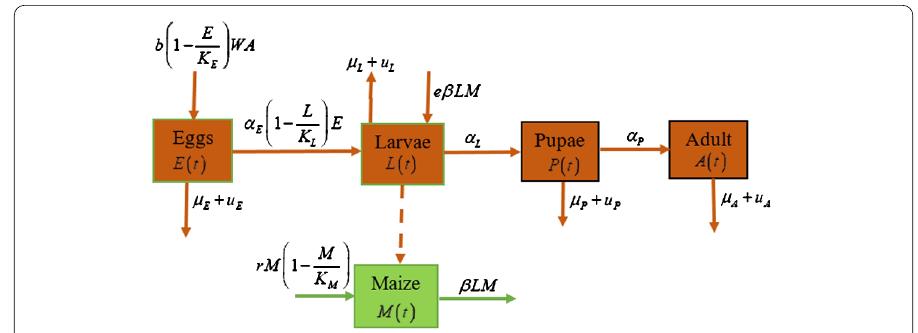
Figure 1 Model flow diagram illustrating the dynamics of fall armyworm in a field of maize biomass. The fall armyworm life cycle is divided into four classes: the egg stage E ( t ), Larvae L ( t ), pupal P ( t ), and the adult stage (Moth) A ( t ). The compartment M ( t ) represents maize plant population. The dotted line demonstrates that fall armyworm larvae are responsible for attacking the maize